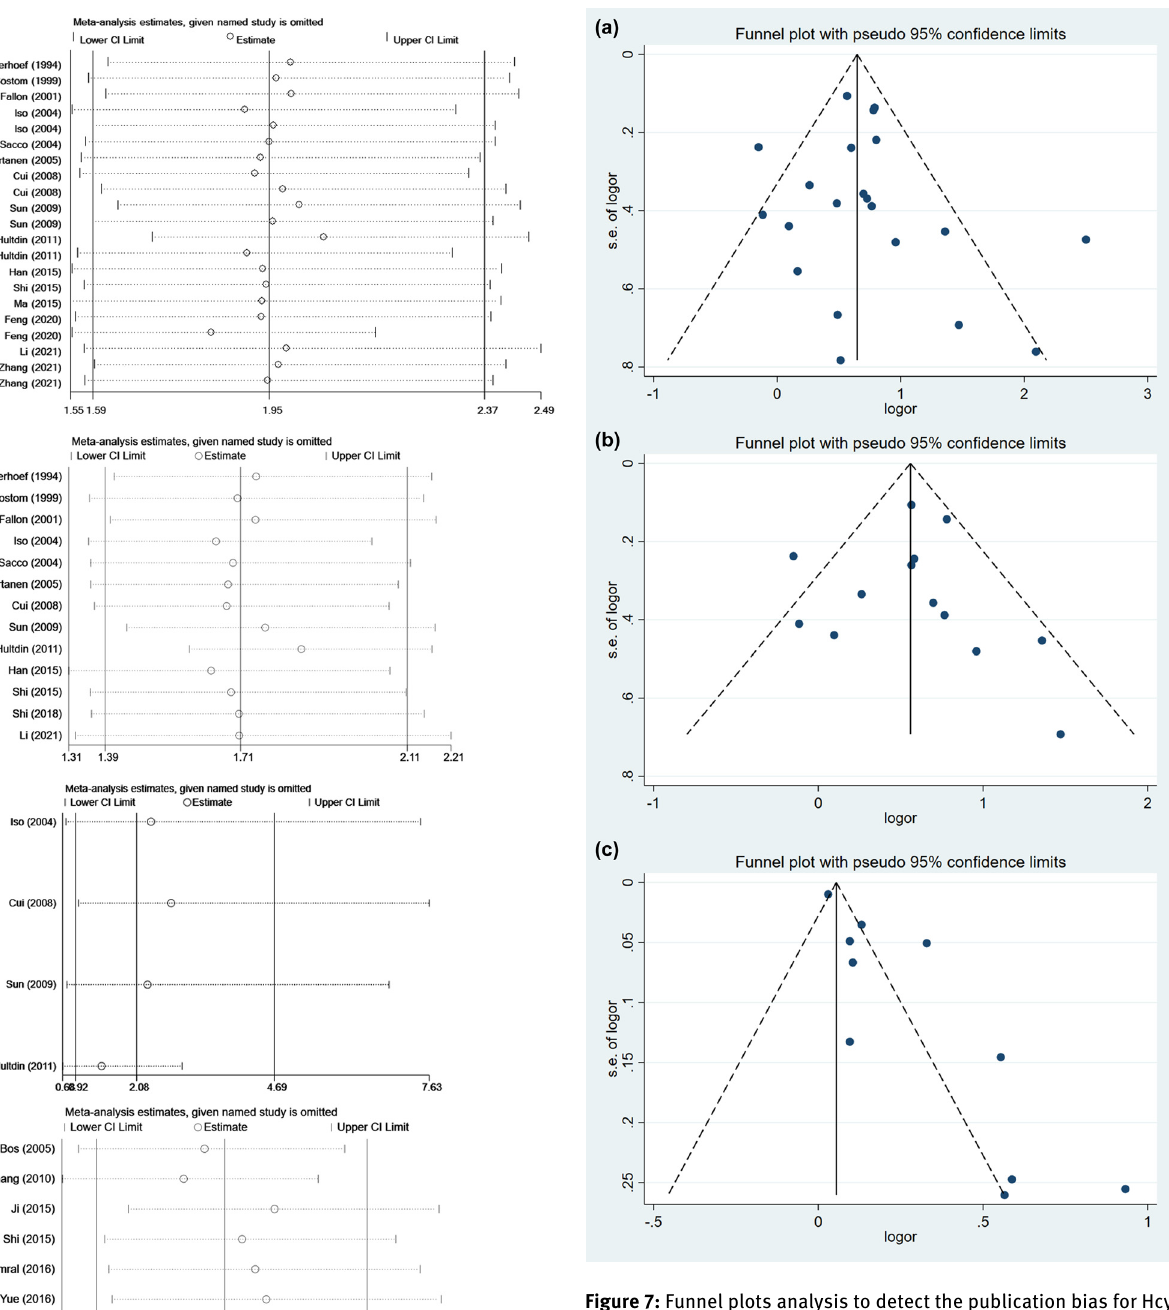
Figure 7: Funnel plots analysis to detect the publication bias for Hcy levels and strokes and no signi fi cant publication bias was noted: ( a ) strokes; ( b ) ischemic strokes, and ( c ) recurrent